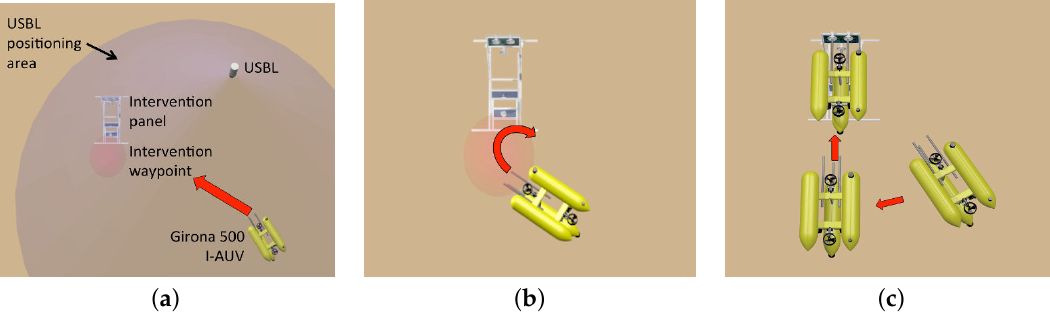
Figure 2. ( a ) Girona 500 I-AUV reaches a waypoint in front of the panel within the ultra-short base line (USBL) accuracy; ( b ) the autonomous underwater vehicle (AUV) centers the panel in its field of view (FoV) in order to obtain several panel detections to improve its relative position; and ( c ) two waypoints are computed to complete the docking maneuver. If the second waypoint is reached, the vehicle pushes forward to finalize and keep the docking.